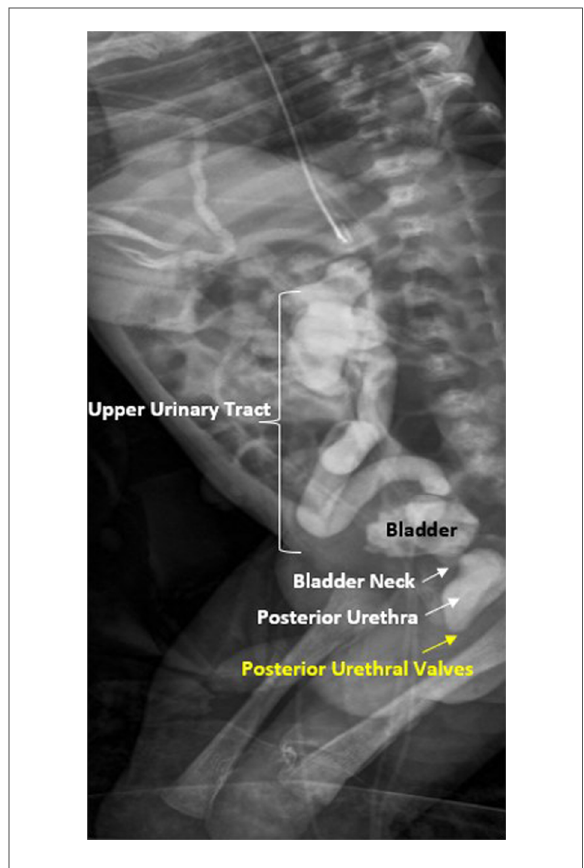
FIGURE 2 Voiding cistouretrography (VCUG) in newborn patient with posterior urethral valves with dilation of posterior urethra and vesico-ureteral re fl